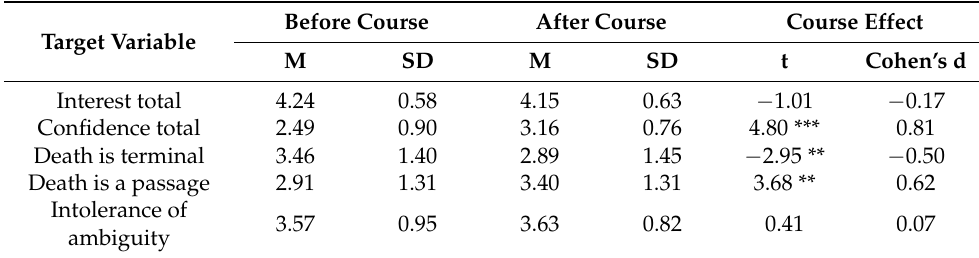
Table 3. Course effect on target variables for the Italian sample (N = 35). Before Course After Course Course Target Variable